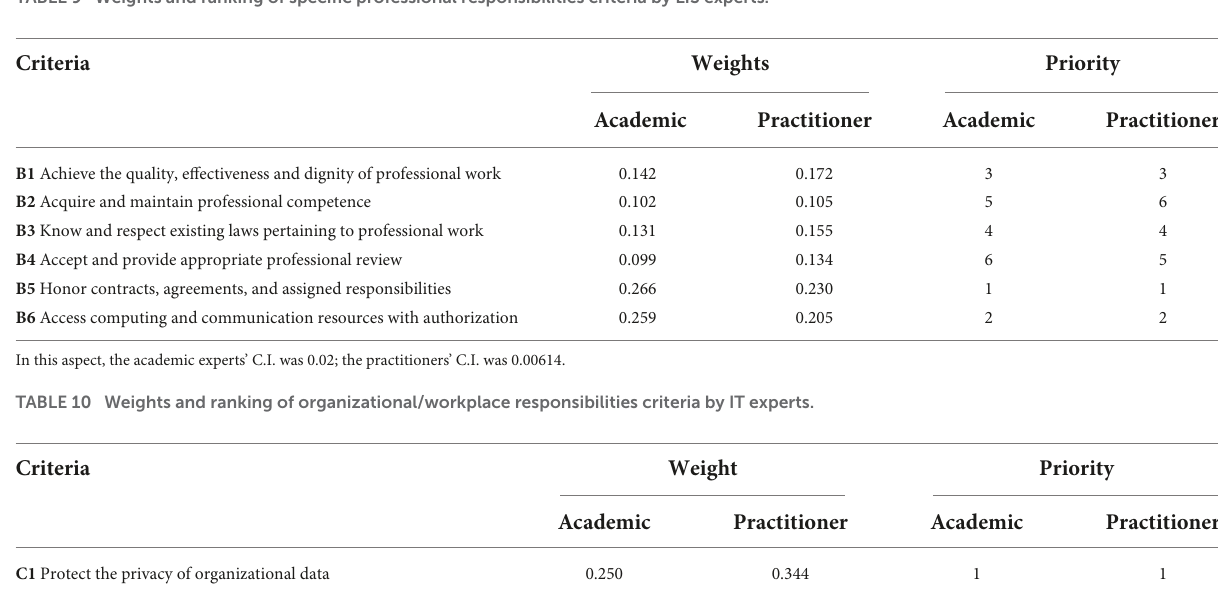
TABLE 9 Weights and ranking of specific professional responsibilities criteria by LIS experts.